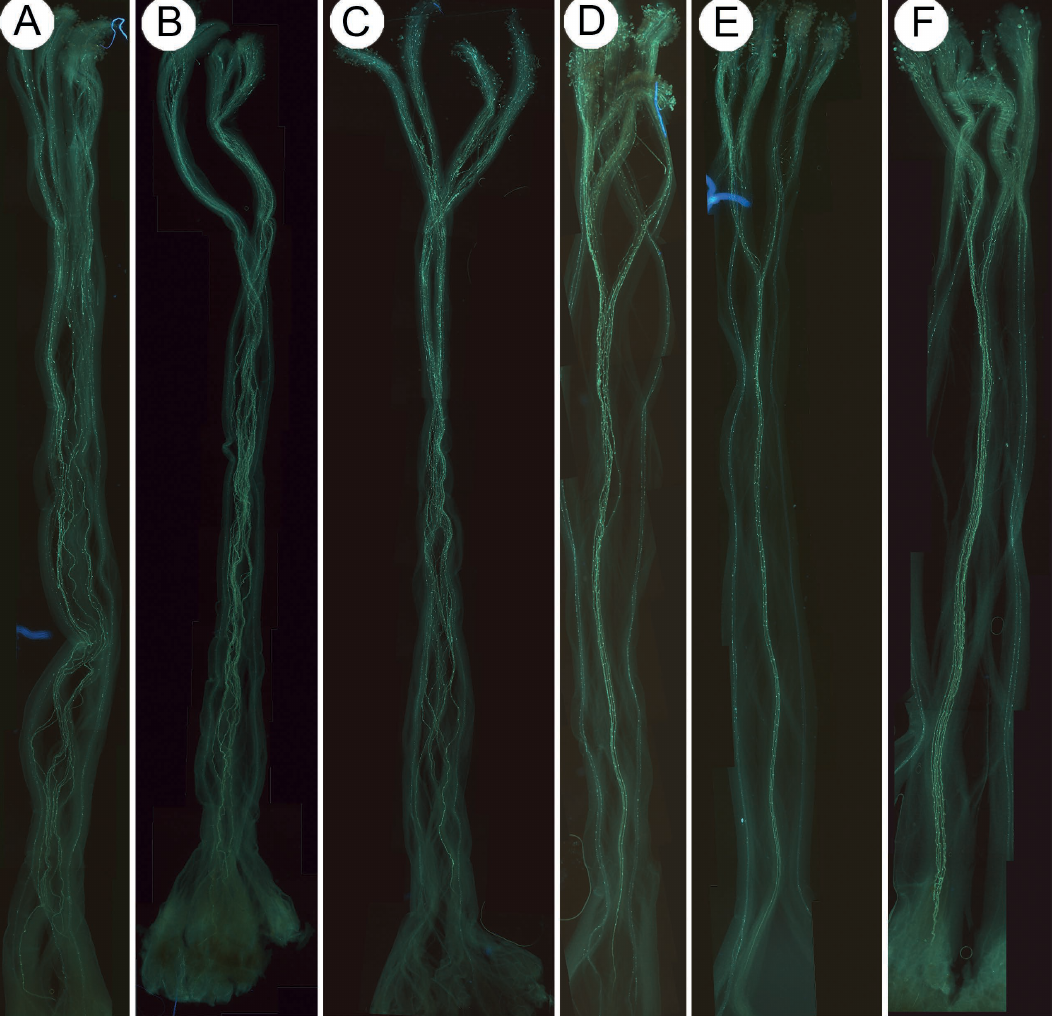
Figure 5 – Pollen tube growth in vivo of C. subcordata after hand-pollination. A . L-morph style 24 h after intermorph cross pollination. B . L-morph style 24 h after intramorph cross pollination. C . L-morph style 24 h after self-pollination. D . S-morph style 24 h after intermorph cross pollination. E . S-morph style 24 h after intramorph cross pollination. F . S-morph style 24 h after